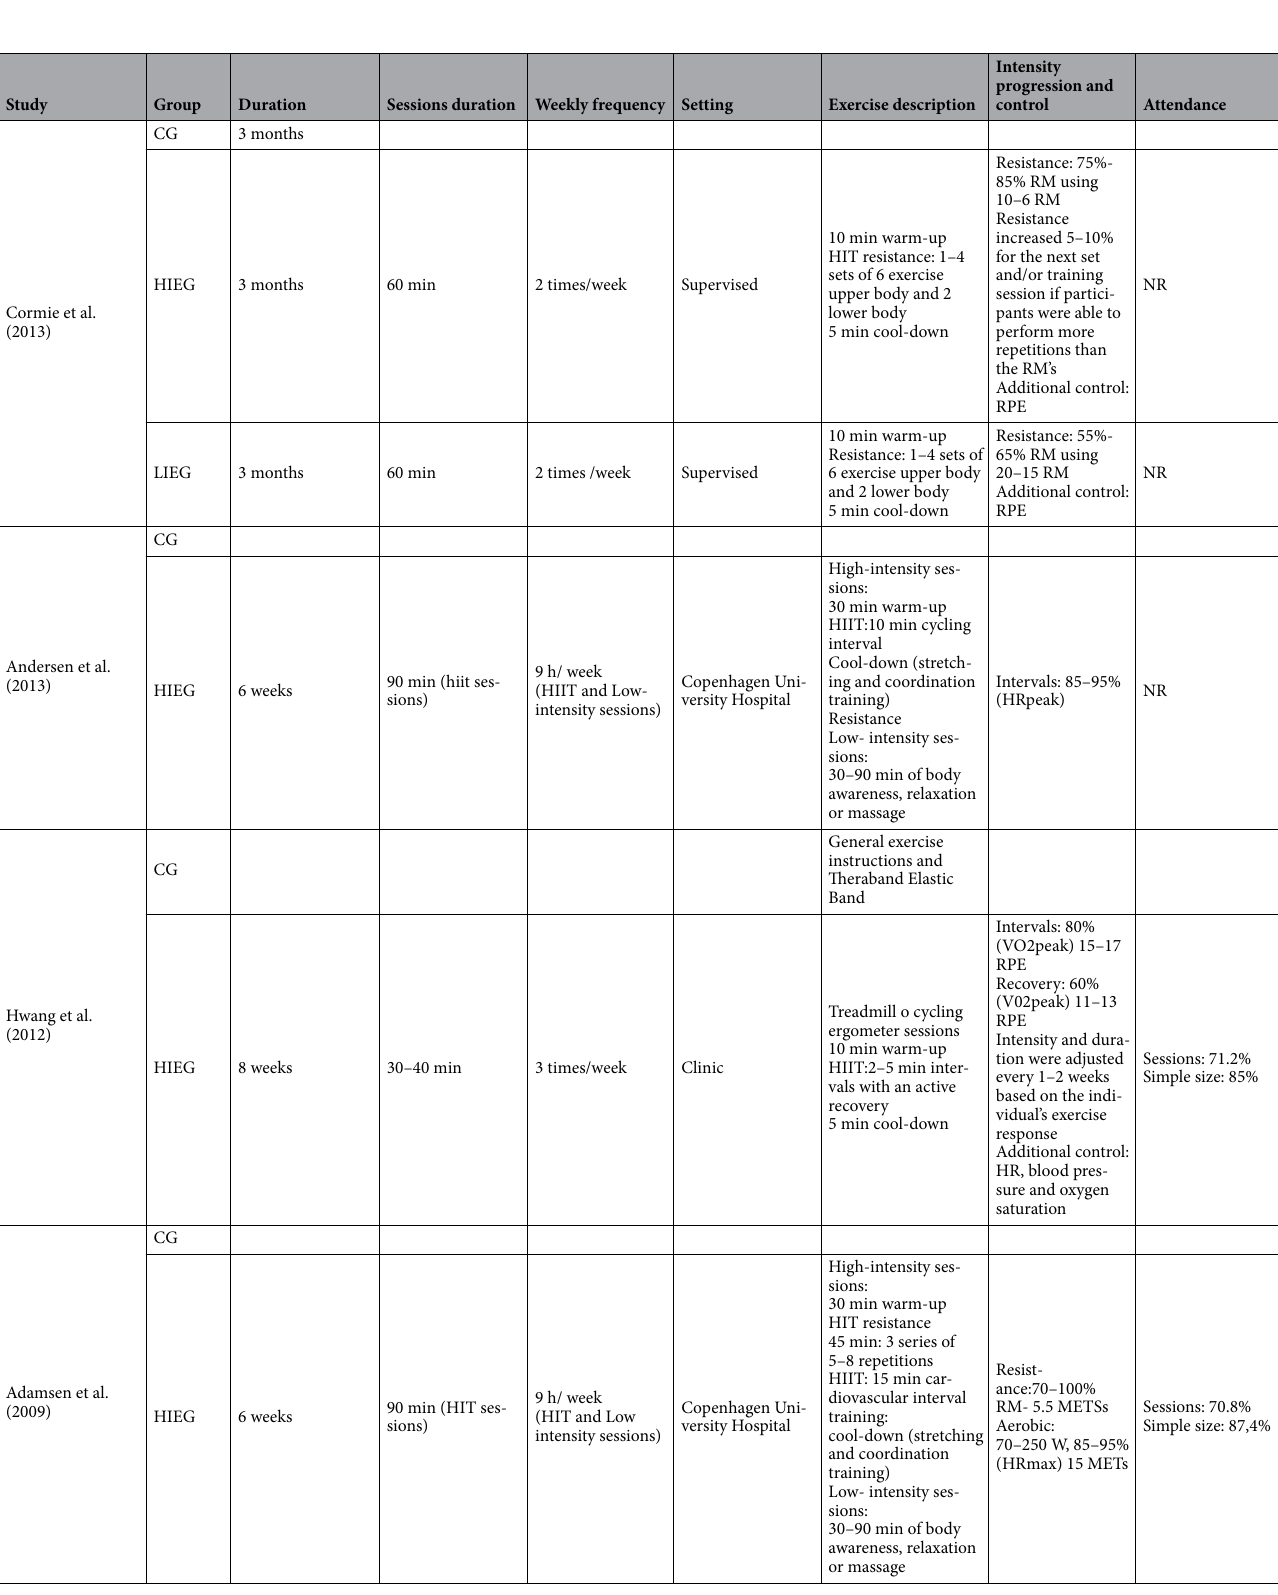
Table 3. Description of the high-intensity exercise interventions included in the meta-analysis. CG: control group, HIEG: high-intensity exercise group, LIEG: low-intensity exercise group, LMIEG: low to moderate exercise group, HIT: high-intensity training, HIIT: high-intensity interval training, MHIT: moderate to high intensity training, METs: Metabolic equivalent of task, RM: maximum repetition, HR: heart rate,RPE: the rating of perceived exertion, MSEC: maximum short exercise capacity, VO 2 : oxygen consumption, NR: not